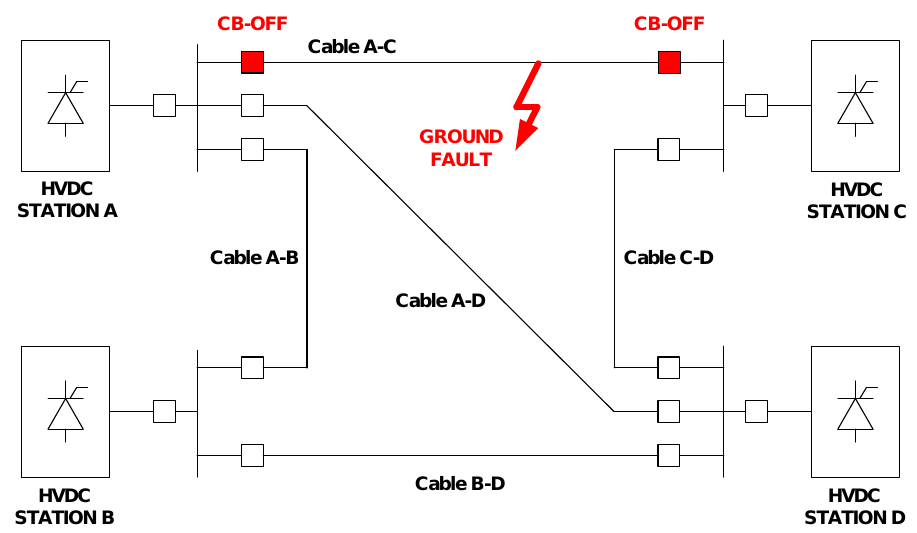
Figure 4. Multiterminal HVDC selective ground fault protection in case of ground fault in Cable A – C.